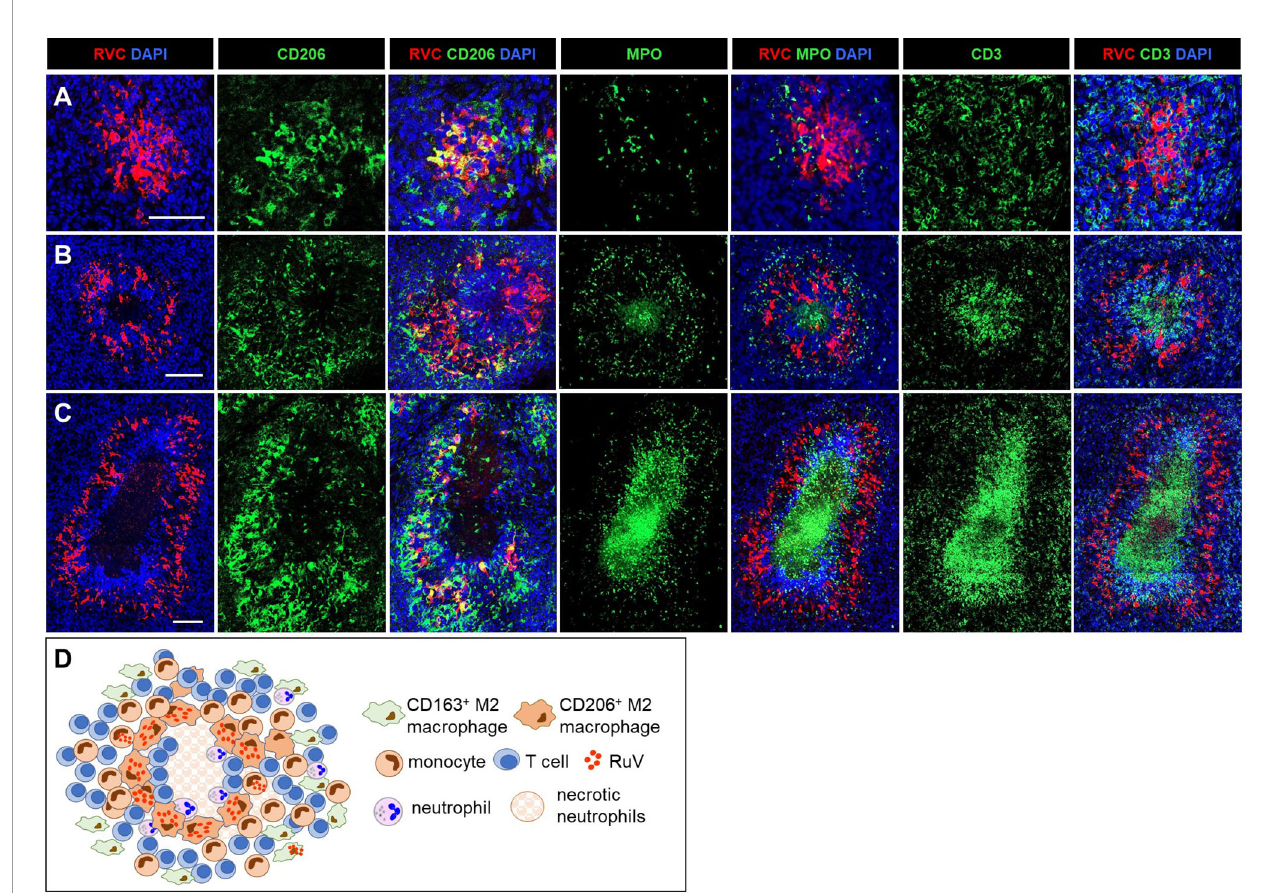
FIGURE 3 | A progression of cutaneous granuloma from M-type to M(n)-type. Histological double staining of sequential tissue slides (P18) for either RVC (red) and one of the cell type markers (green). Non-necrotizing M-type granuloma contains RVC + CD206 + M2 macrophages in the center with infrequent, mainly RVC - neutrophils and abundant surrounding RVC - CD3 + T cells (A) . Necrotizing M(n)-type granulomas with MPO + and CD3 + staining of the necrotic centers surrounded by RVC + CD206 + macrophages (B, C) . Notice a rim CD3 + T cells located between acellular necrotic center and RVC + CD206 + macrophages (C) . Scale bar: 100 µM. Schematic of M(n)-type RuV-associated granuloma pattern (D)